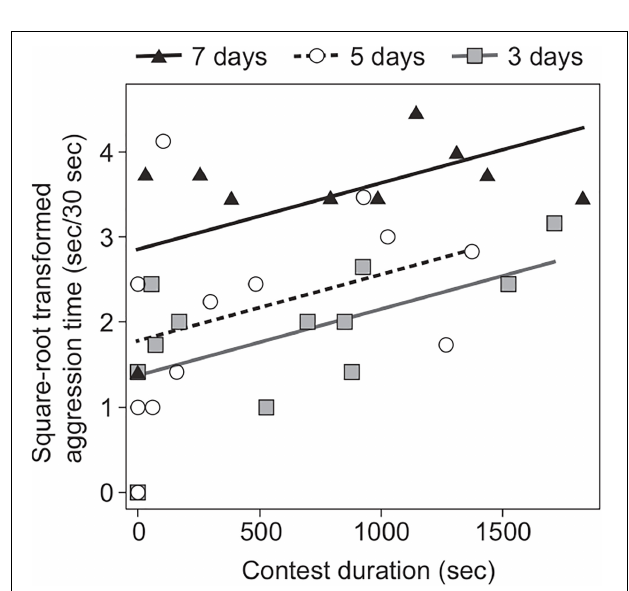
FIGURE 2 | The relationship between the contest duration and the attack duration of the subordinates. Regression lines for different separation time intervals are obtained from the reduced ANCOVA model. The aggression duration in 7-day period of separation was significantly longer than that in 5- and 3-day periods (see